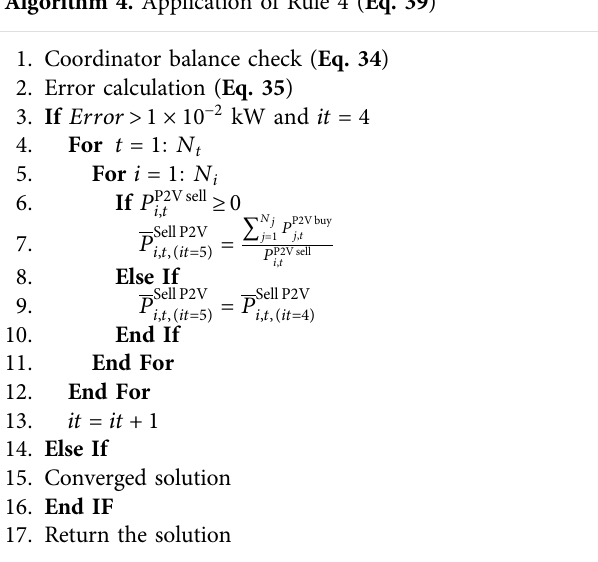
Algorithm 4. Application of Rule 4 ( Eq. 39